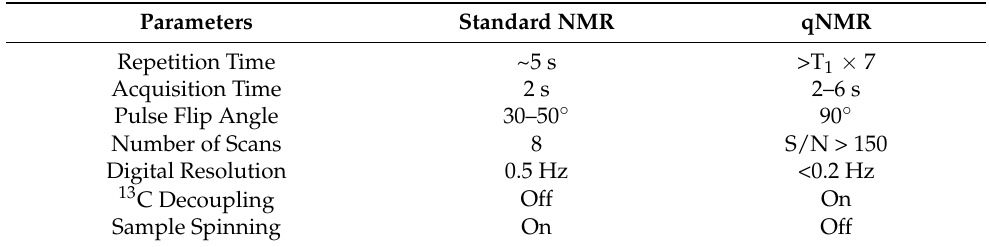
Table 3. Comparison of typical parameters for standard and quantitative measurement